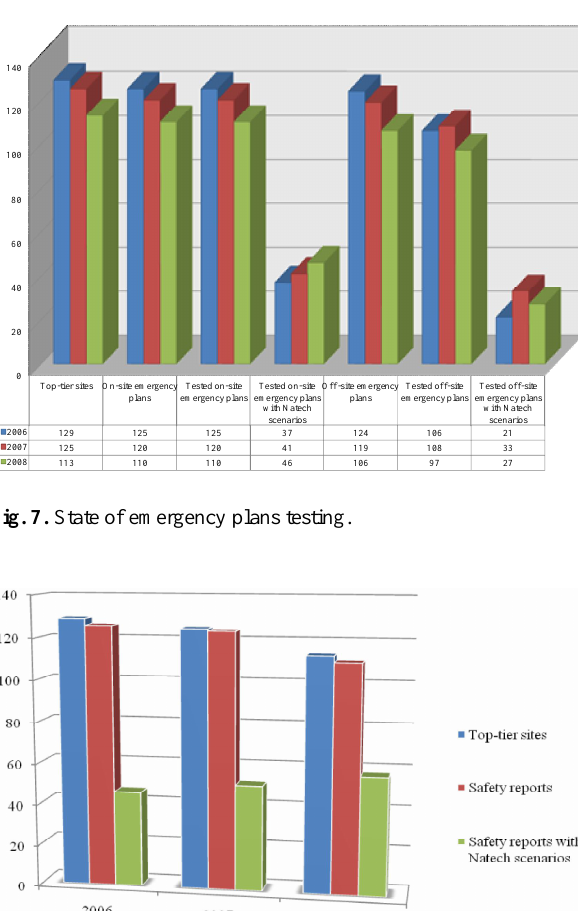
Fig. 8. Safety reports including Natech Figure 8. Safety reports including Natech scenarios 3